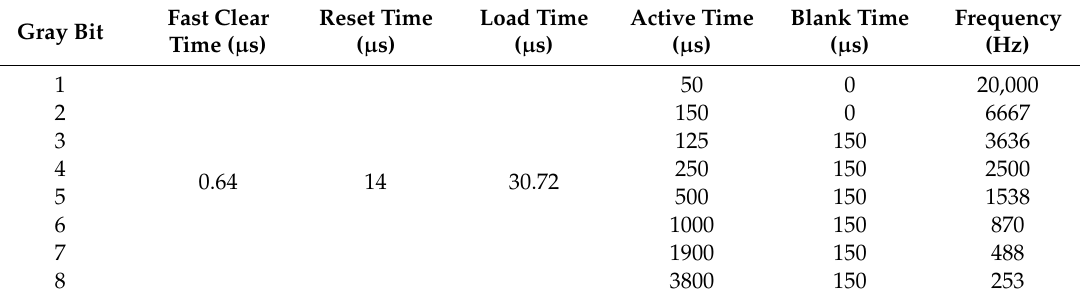
Table 1. Relevant parameters of DLP7000.